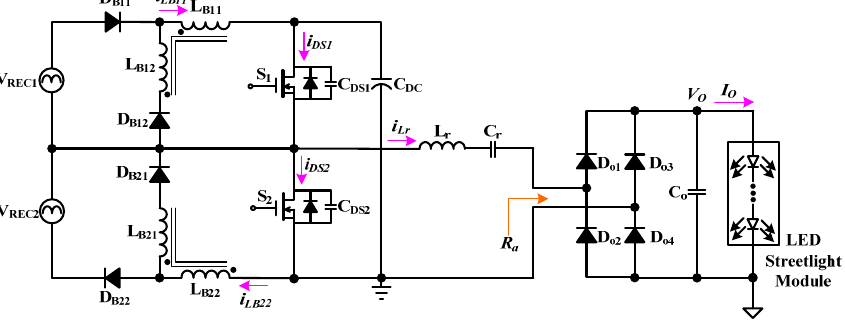
Figure 4. Simplified circuit of the presented single-stage LED driver for streetlight applications.